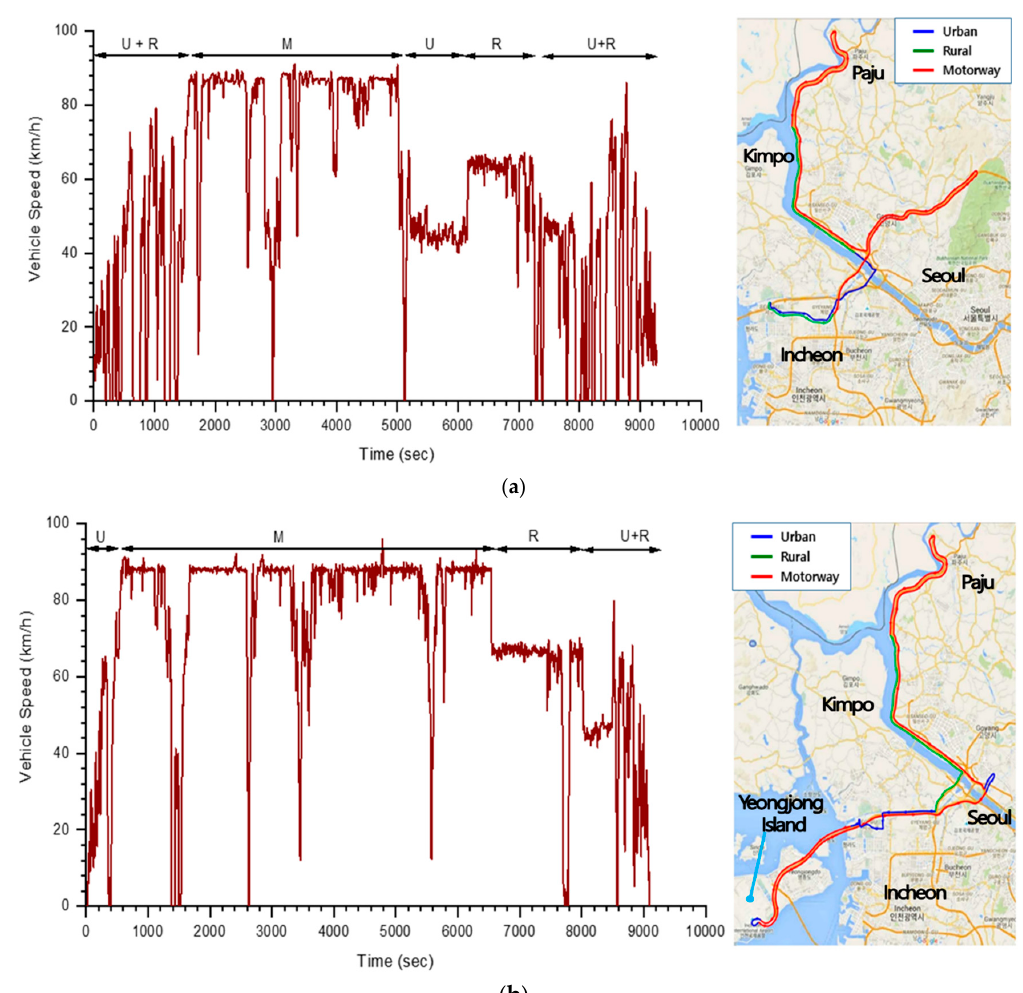
Figure 1. Real driving emission (RDE) test routes for heavy-duty vehicles. ( a ) RDE test route A for trucks with gross vehicle weights (GVWs) less than 12 tons; urban (U): 45%, rural (R): 25%, motorway (M): 30%. ( b ) RDE test route B for trucks with GVWs more than 12 tons and buses; urban (U): 20%, rural (R): 25%, motorway (M): 55%.